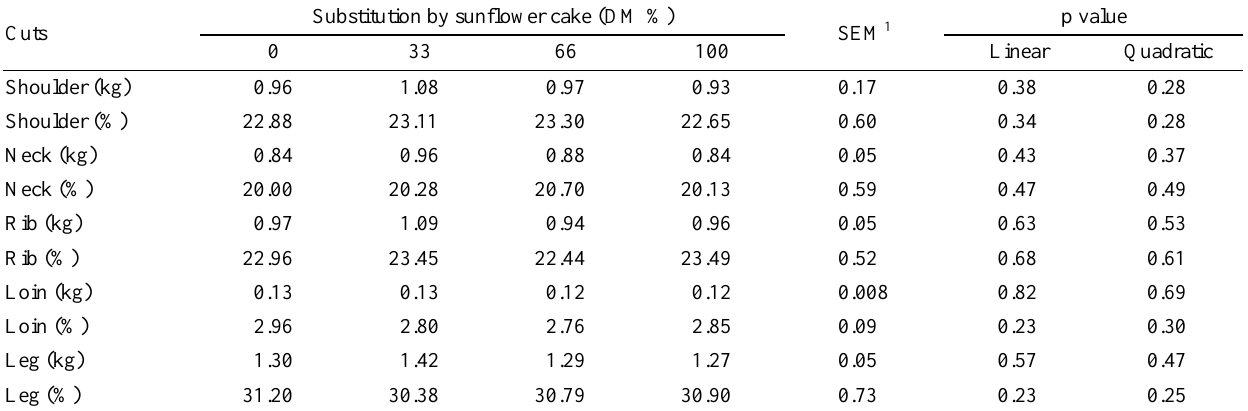
Table 5. Yield and commercial cuts of 1/2 Boer kids fed diets containing sunflower